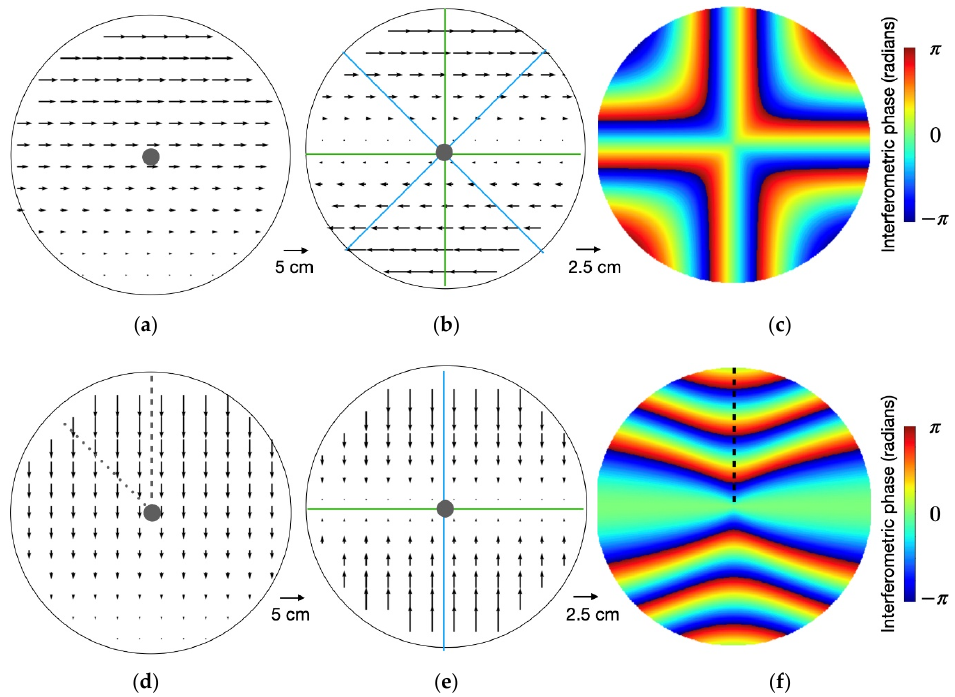
Figure 4. ( a ) Right-lateral shear displacement within the footprint of the GPRI. ( b ) Motion relative to the GPRI sensor. ( c ) Modeled repeat-scan interferogram of the shear field. ( d ) Convergence displacement within the footprint of the GPRI. ( e ) Motion relative to the GPRI sensor. ( f ) Modeled repeat-scan interferogram of the convergence field. Along the green lines in ( b , e ) there is no change in relative motion that will have zero phase change in the interferograms. Blue lines indicate orientations of maximum motion gradient in look-direction and will exhibit most pronounced phase change. The change in relative motion over the 5 km range is 5 cm. Dashed and dotted lines in panel d and f indicates example orientations in stare-mode (see text for details).